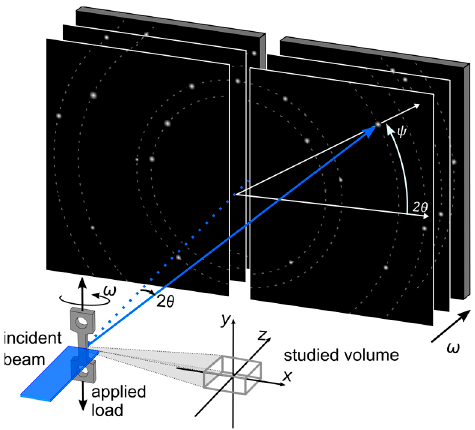
Figure 1. Experimental set-up for ff-HEDM.